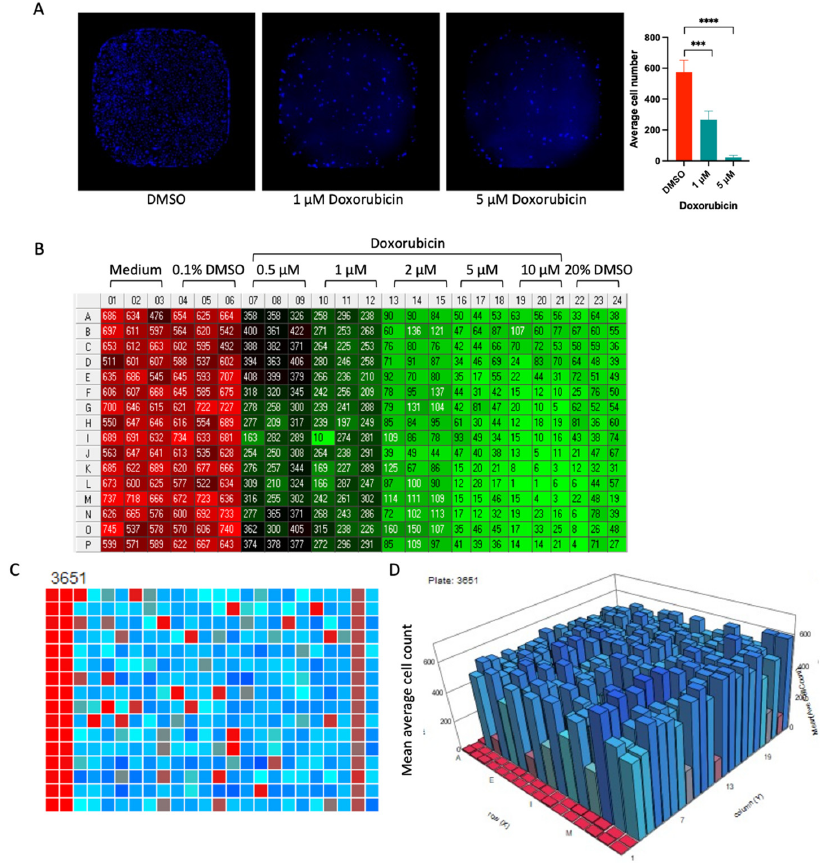
Figure 1. Development of a primary assay for screening the compound. ( A ) Representative images of cells following doxorubicin treatment. Quantitation of cell number shows a significant decrease in proliferation with doxorubicin. *** and **** represent p < 0.001 and 0.0001, respectively. ( B ) A representative plate showing cell numbers as counted by Hoechst staining for Z-prime calculation. Medium and 0.1% DMSO as negative control, and different concentrations of doxorubicin and 20% DMSO as positive controls. ( C ) Mean average cell numbers plotted in a plate format. Plate showing positive controls (5 µ M doxorubicin, 1st , and 2nd columns, 20% DMSO, 23rd column), negative controls (0.1% DMSO) 24th column, and experimental compounds 3–22 columns. Color range Red 780 and green 320. ( D ) Mean of average cell counts was plotted to identify edge